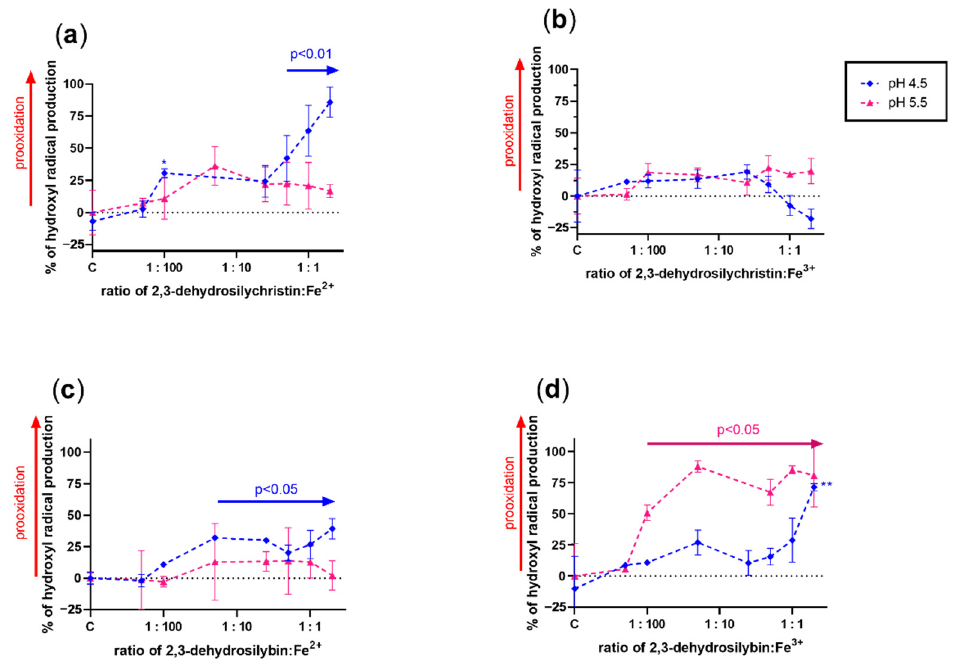
Figure 9. Effect of 2,3-dehydrosilychristin and 2,3-dehydrosilybin on the iron-based Fenton chemistry at pH 4.5 and 5.5: ( a ) 2,3-dehydrosilychristin + Fe 2+ ; ( b ) 2,3-dehydrosilychristin + Fe 3+ ; ( c ) 2,3- dehydrosilybin + Fe 2+ ; ( d ) 2,3-dehydrosilybin + Fe 3+ . Statistical significance vs. the control (C: positive blank—the Fenton reaction with the solvent) is shown directly or for isolated points as * p < 0.05 or ** p < 0.01.